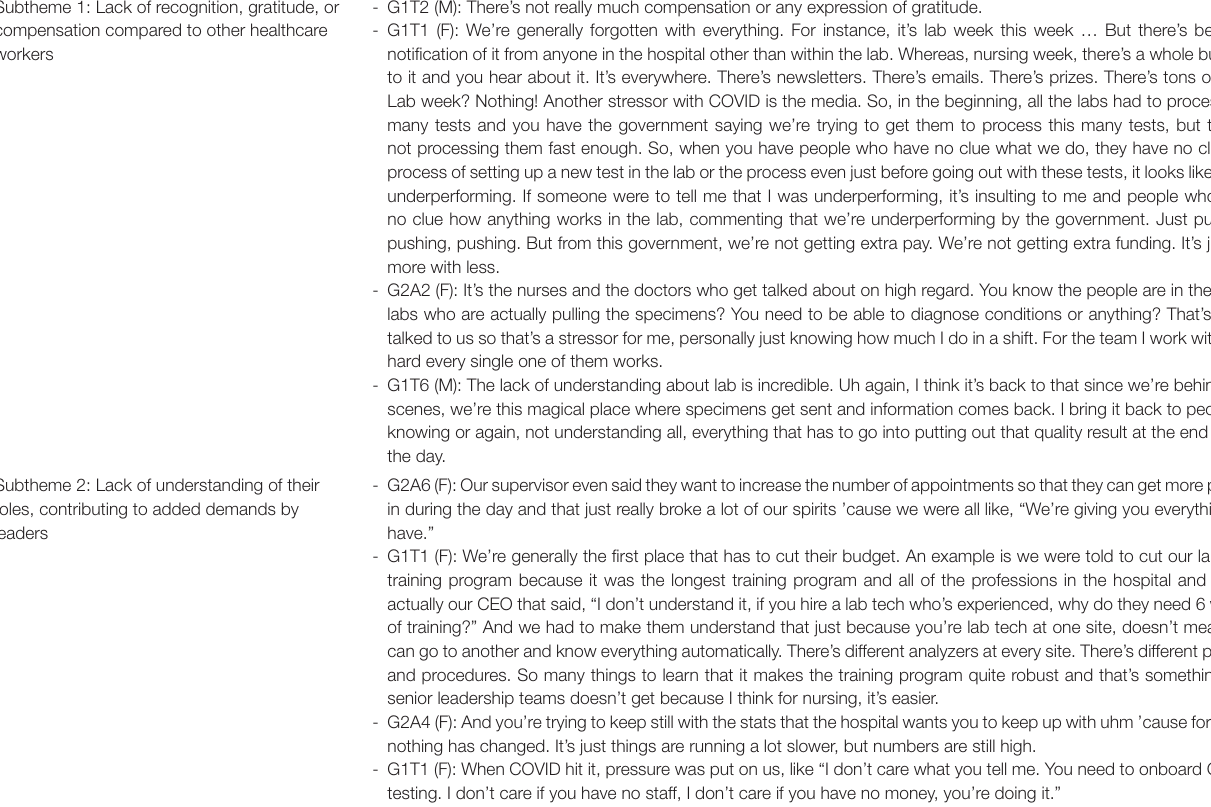
TABLE 4 | Theme 2: The pandemic reinforced that medical laboratory employees are forgotten within the healthcare system. Subtheme 1: Lack of recognition, gratitude, or compensation compared to other healthcare